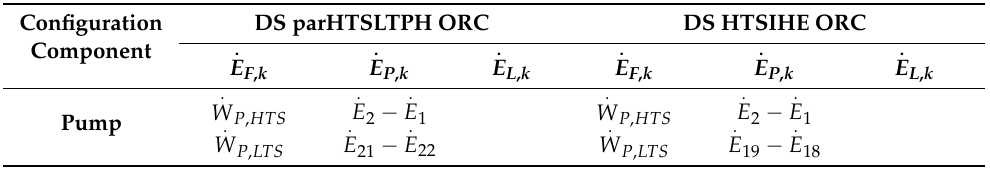
Table A4. The exergy relations used in the conventional exergy analysis for the DS parHTSLTPH ORC and DS HTSIHE ORC